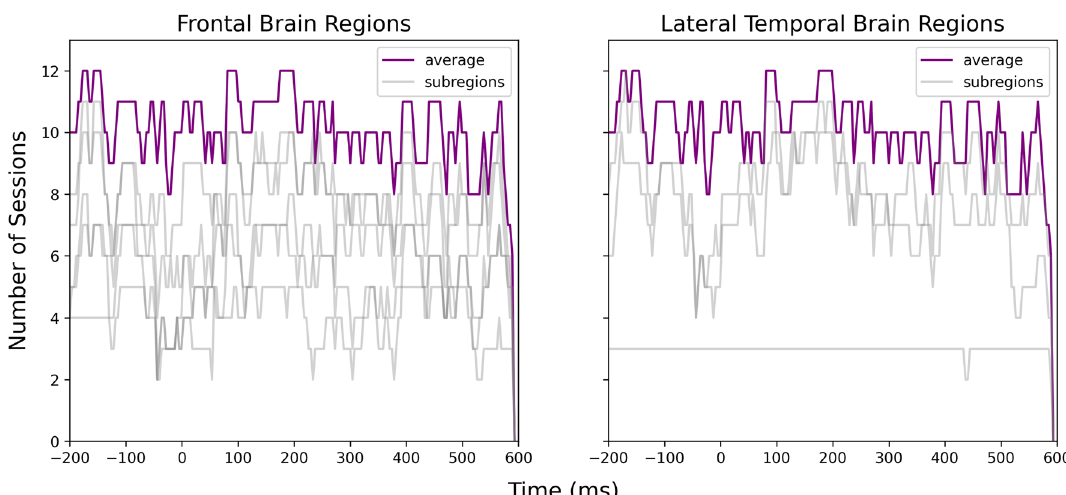
Figure 9. Number of sessions showing significant differences in the iEEG windows sampled around phrase boundaries and note onsets at each time point. The purple lines were obtained by averaging all channels within the frontal and lateral temporal brain regions. The light gray lines were obtained by averaging the channels within sub-regions that contributed to the frontal and lateral temporal